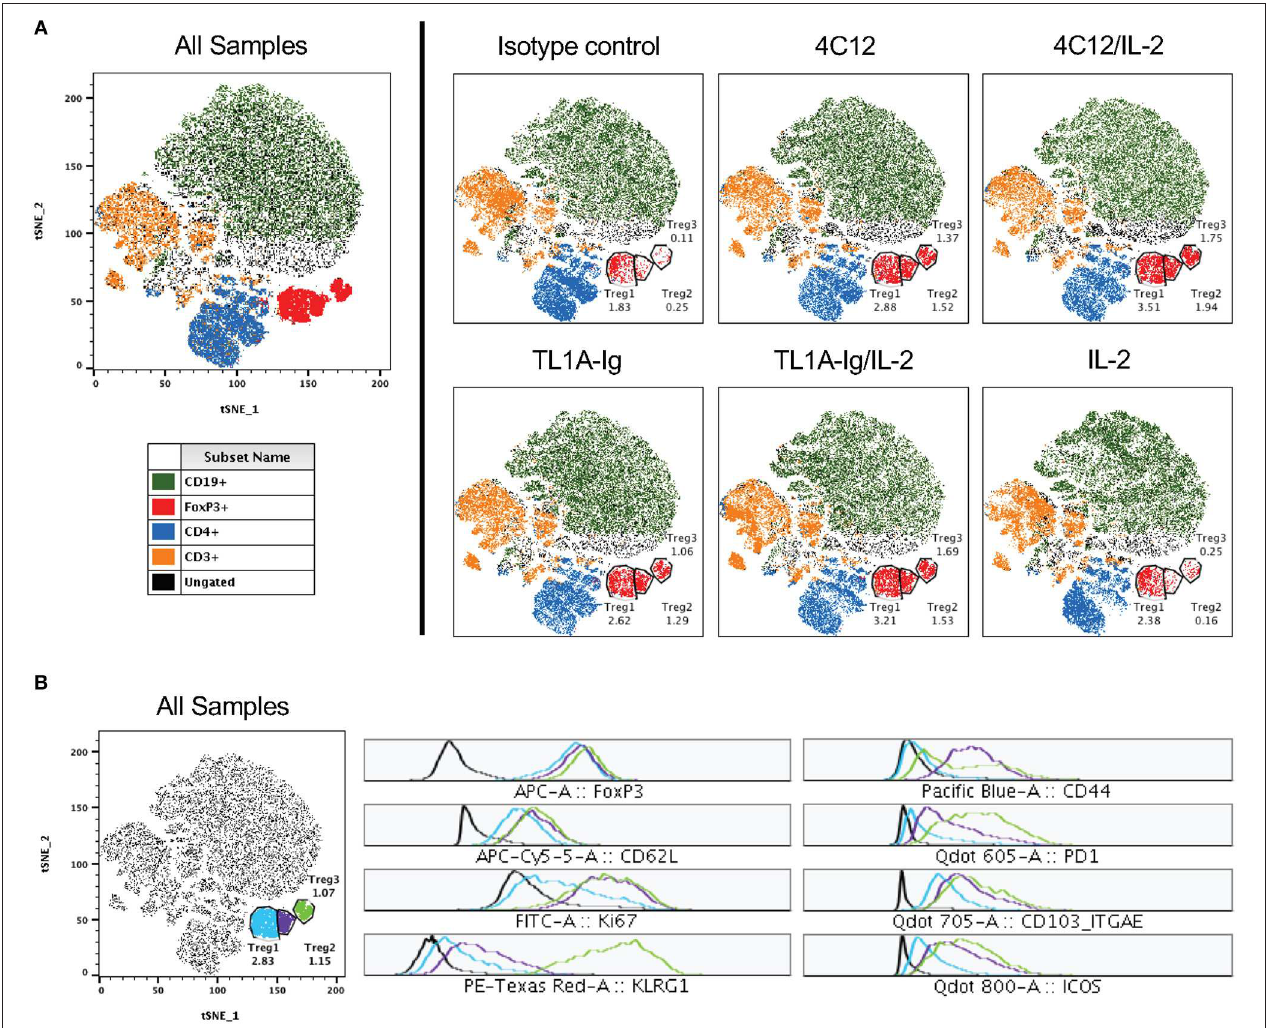
FIGURE 3 | Regulatory T cells comprise a heterogenous population with distinct activated subsets significantly increased following DR3 activation. Live lymphocytes (gated on FSC versus SSC and a live/dead marker) from all samples were concatenated and subjected to tSNE analysis (data shown are pooled from two independent experiments). (A) Shown on left is the tSNE plot for all samples and on right for each treatment group. Clustered populations were identified using the indicated markers and three regulatory T cell populations are gated as shown. The percent of cells in each Treg population are shown for each treatment group on the tSNE plots. (B) Displayed on left is the tSNE plot for all samples from (A) with each Treg population differentially labeled. At right, histograms for each Treg population are shown for the indicated analytes.